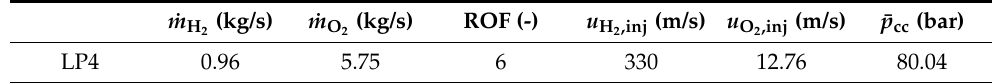
Table 1. Operation parameter of case